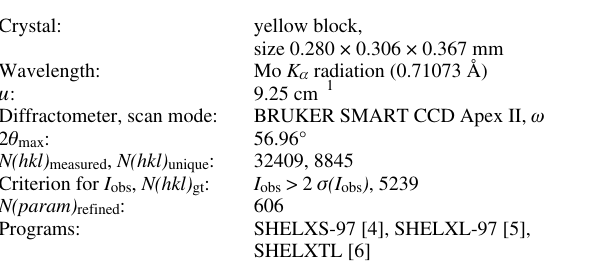
Table 1. Data collection and handling.